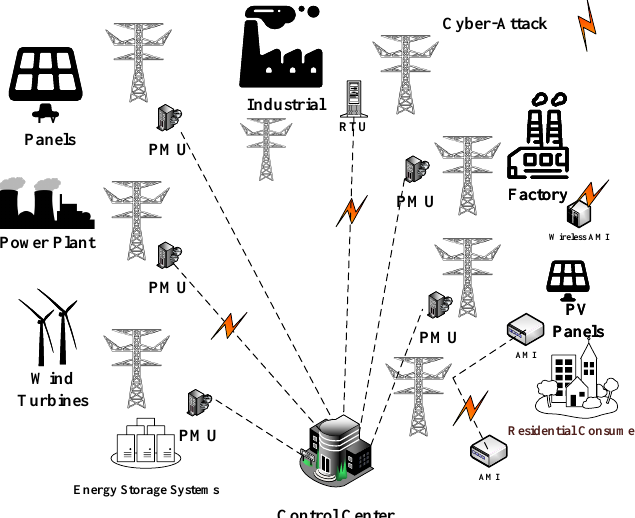
Figure 1. Cyber-threat for smart